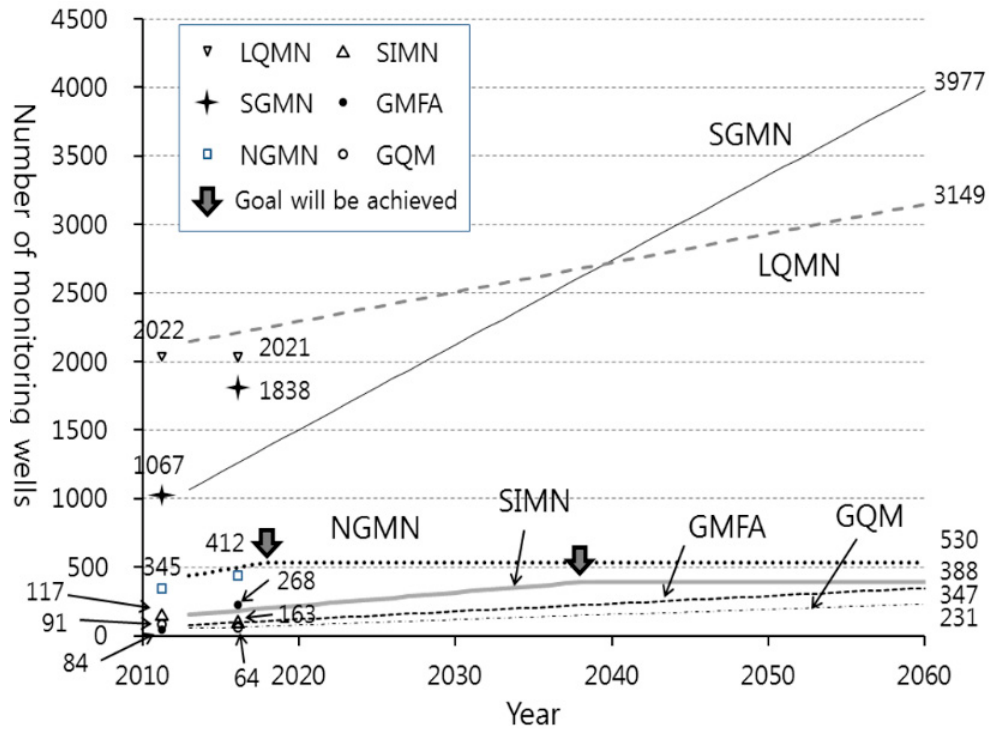
Figure 5. Forecasting groundwater monitoring networks considering recent trends. Note: Symbols denote numbers of groundwater monitoring wells in 2011 and 2016.